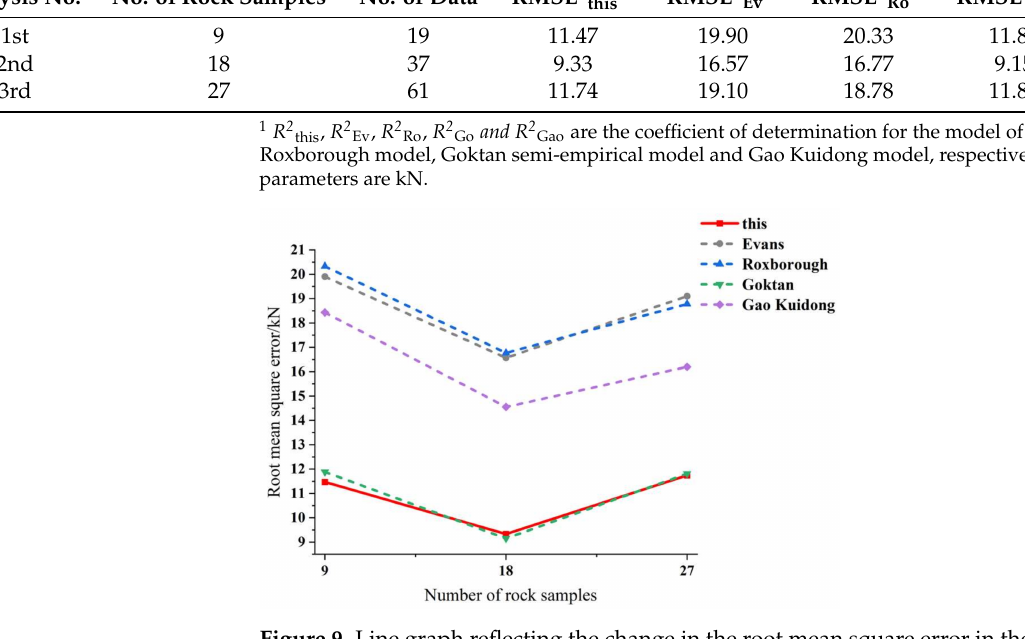
Figure 9. Line graph reflecting the change in the root mean square error in the three